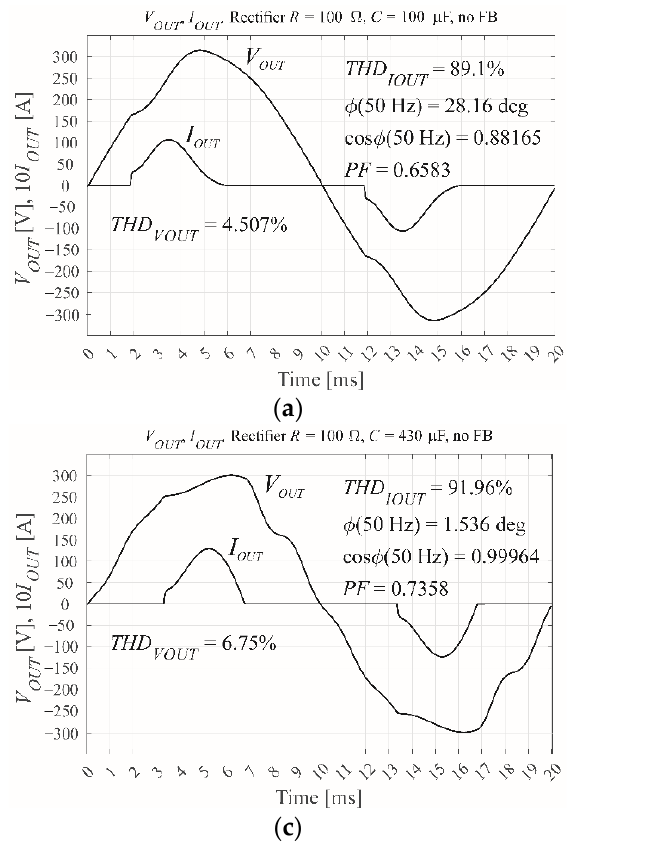
Figure 5. The simulated output voltage and current for the VSI when subject to a nonlinear rectifier RC load, showing ( a ) open loop with R = 100 Ω, C = 100 μF, and PF = 0.7, ( b ) CDM control with R = 100 Ω, C = 100 μF, and M = 0.6, ( c ) open loop with R = 100 Ω, C = 430 μF, and PF = 0.7, and ( d ) CDM control with R = 100 Ω, C = 430 μF, and M = 0.6.